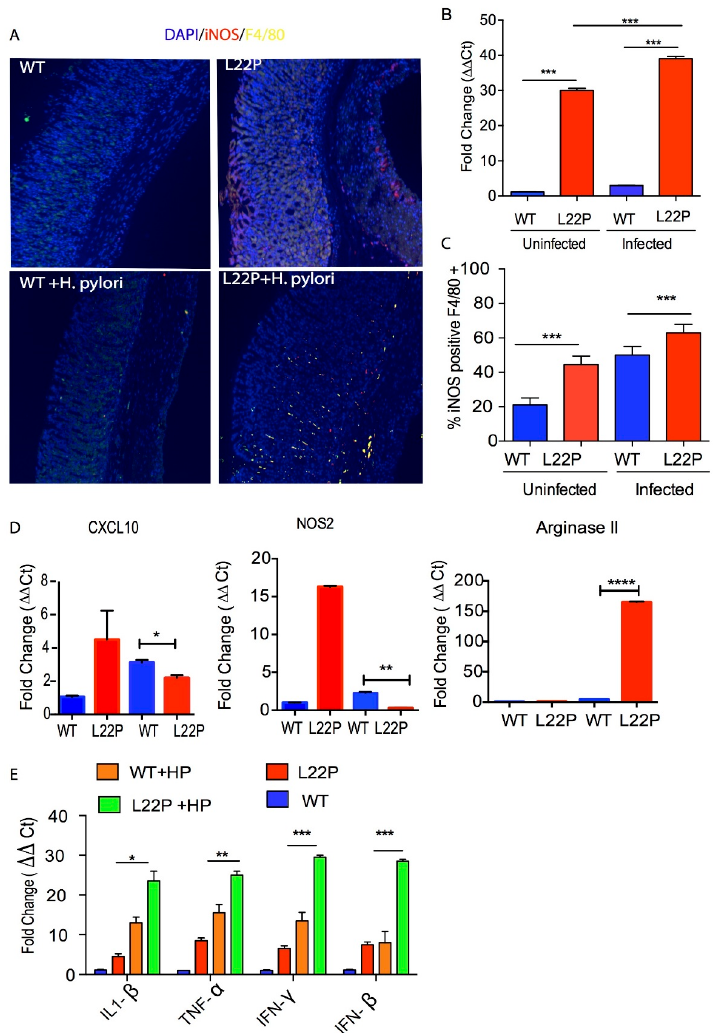
Figure 3. H. pylori infection synergize with POLB mutation to increase inflammatory response. ( A ) Localization of iNOS producing macrophage using immunocytochemistry, macrophage stained with F4/80 antibody (green stain) and iNOS stained with antibody (red stain); ( B ) Gene expression of iNOS using qRT-PCR from WT and L22P mice stomach tissue extract with and without H. pylori infections; ( C ) Estimated percent of iNOS producing macrophage (F4/80+) from stomach extract of WT and L22P mice with and without H. pylori infections. The experiment was done using a flow cytometer and data analysis was performed using FLowJo software; ( D ) qRT-PCR of macrophage mediated gene expression from levels from macrophage I (CXCL10 and NOS2) and Macrophage II (Arginase II) tissue extract derived from WT and L22P mice with or without H. pylori infection; ( E ) qRT-PCR of cytokine gene expression from WT and L22P mice with or without H. pylori infection. All statistical data analyses were processed using GraphPad prism. The statistical significance represented * p < 0.05; ** p < 0.01; *** p < 0.001; and **** p <